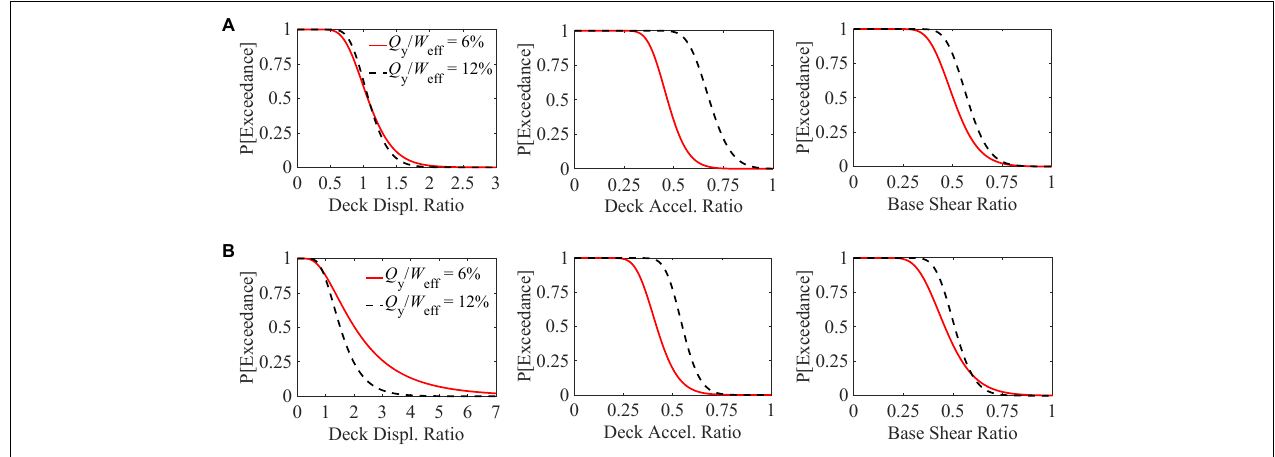
FIGURE 12 | Probability of exceeding the ratio of the maximum resultant responses of the isolated long-pier models from a given value for the (A) FF; (B) NF excitations.